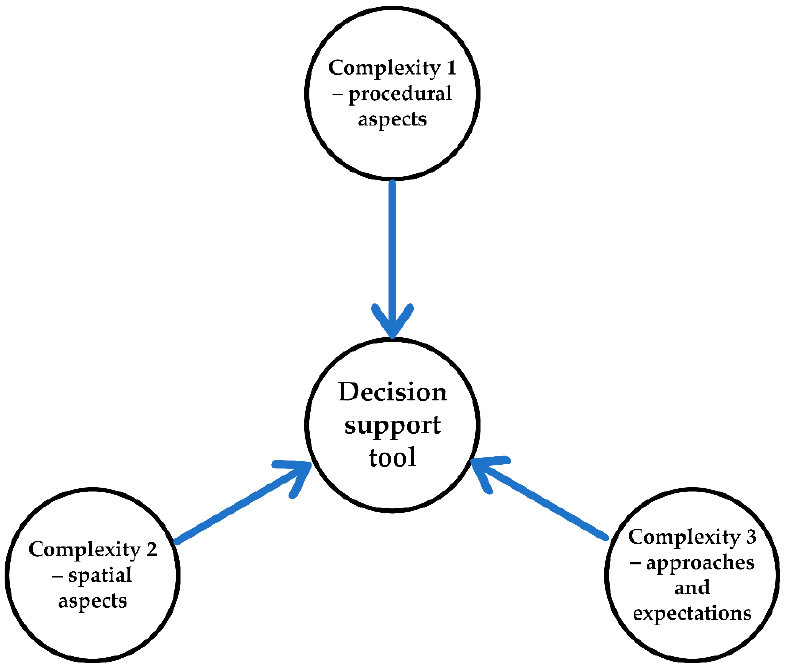
Figure 1. Conceptual framework for a decision support tool in spatial planning in relation to holistic approach to the 3 complexities.